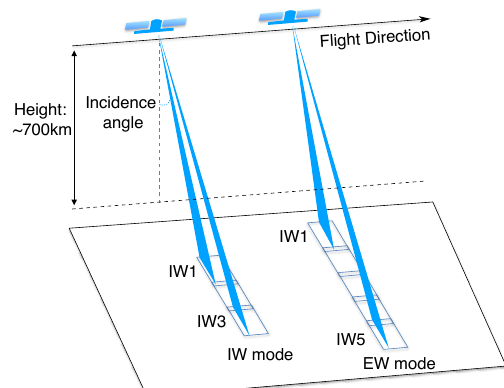
Figure 2. Sentinel-1 Interferometric Wide Swath (IW) and Extra Wide Swath (EW) acquisition modes. The incidence angle varies in a relatively big range.